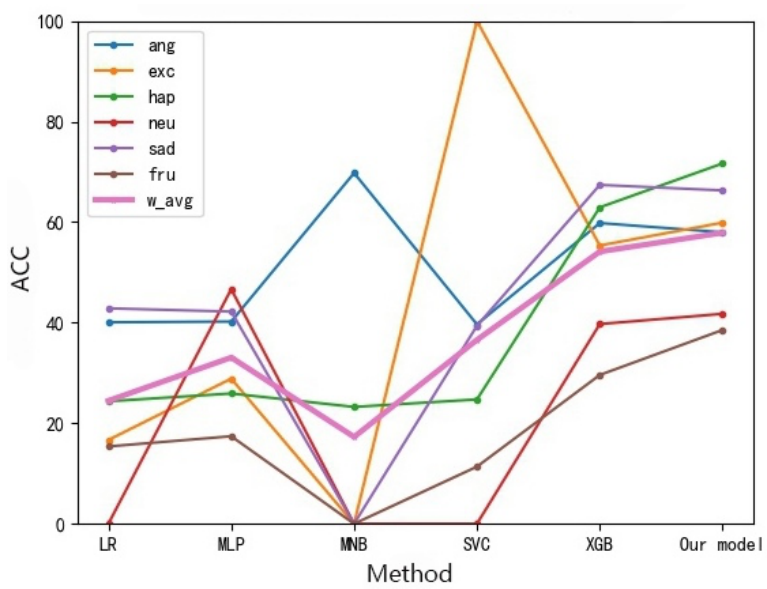
Figure 12. Fine-grained Emotion Accuracy Rate Analysis of Different MOCAP Methods (Audio).